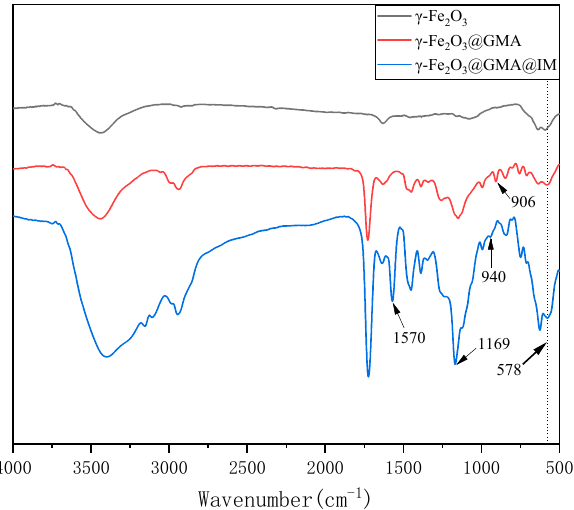
Figure 3. FTIR diagram of γ -Fe 2 O 3 @GMA@IM.